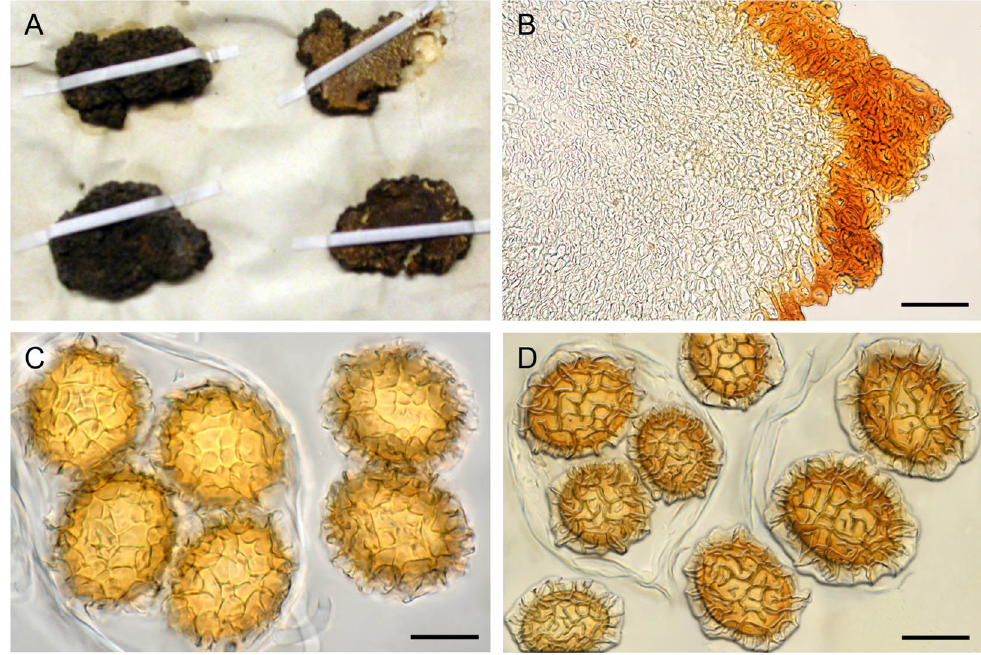
Figure 5. T. bituminatum . ( A ) Ascomata in section (lectotypes). ( B ) Peridium structure. ( C ) Asci and ascospores with regular reticula. ( D ) Asci and ascospores with labyrinthine pseudoreticula. Bars = 20 µm.